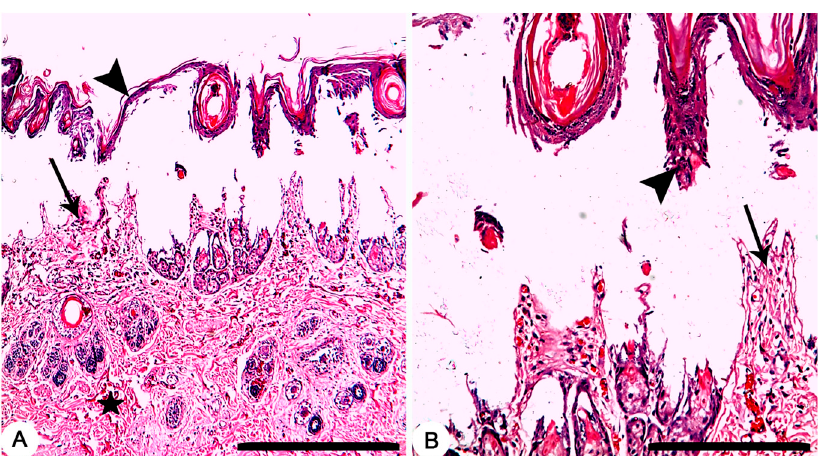
Figure 4. Skin, Rabbit. ( A , B ) Thermally induced skin burns using aluminum stamp (80 °C/ 14 s), showing second ‐ degree burns which characterized by necrosis of both epidermal (arrowheads) and dermal (arrows) skin layers with a separation between epidermal and dermal layers, as well as denaturation of dermal collagens bundles (star). HE stain; Bars ( A ) 500 µ m; ( B ) 100 µ